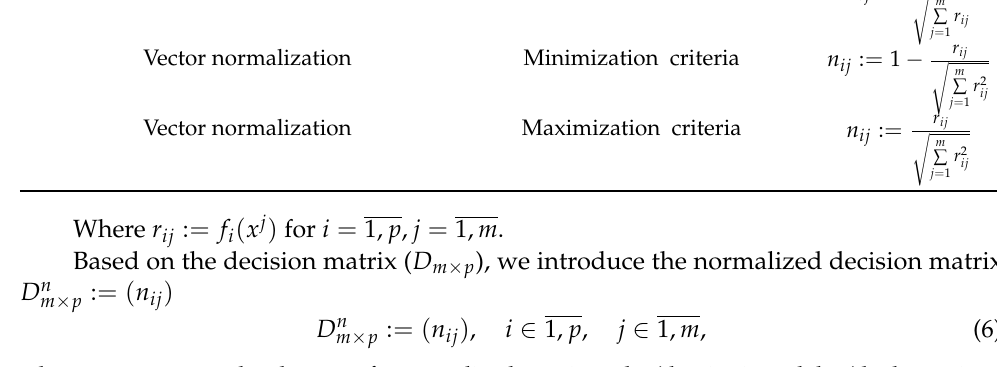
1 rij = (cid:115) m ij : ∑ 1 rij j = 1 m ∑ r ij j = 1 r 2 ij j = 1